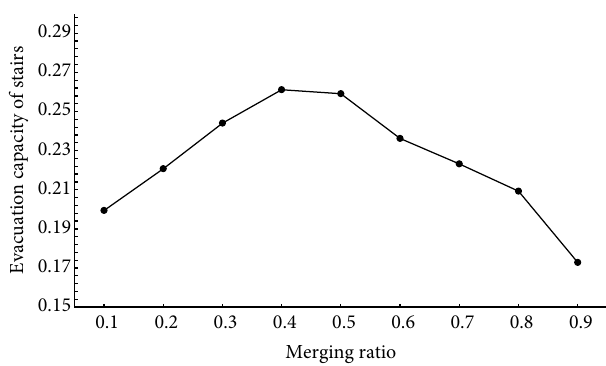
Figure 7: Evacuation capacity of stairs for different merging